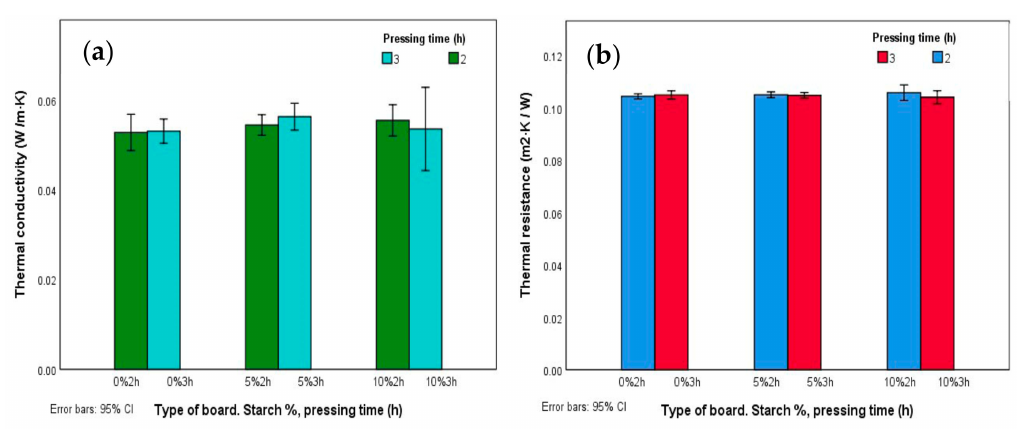
Figure 8. Thermal conductivity ( a ) and resistance ( b ) according to type of